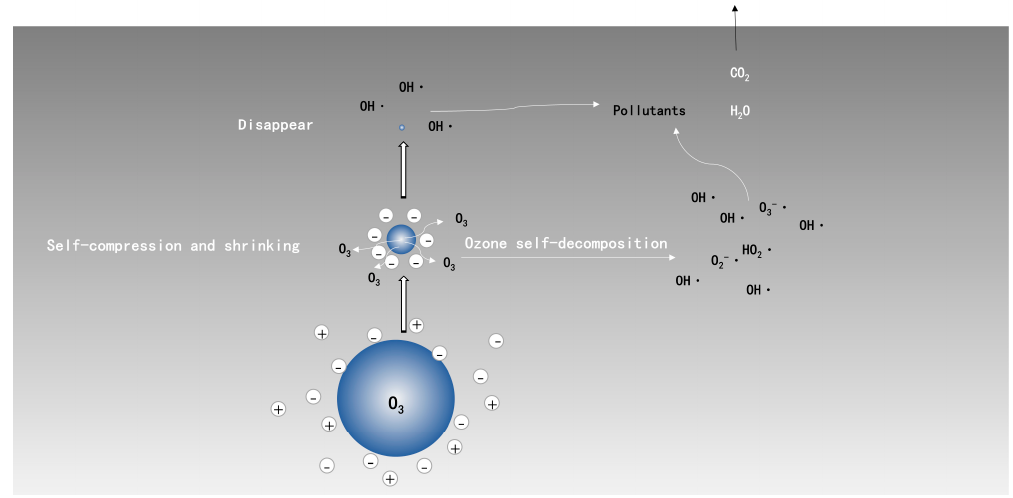
Figure 2. Schematic diagram of ozone-microbubble in liquid phase.